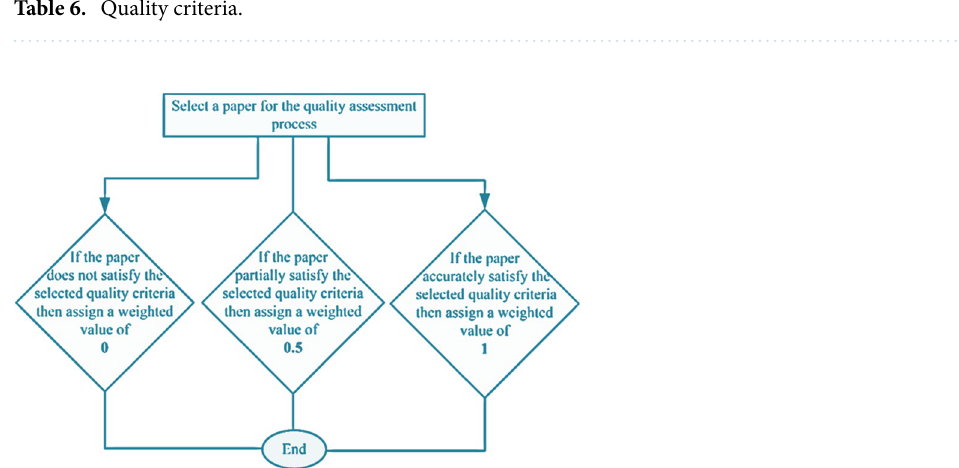
Table 6. Quality criteria.